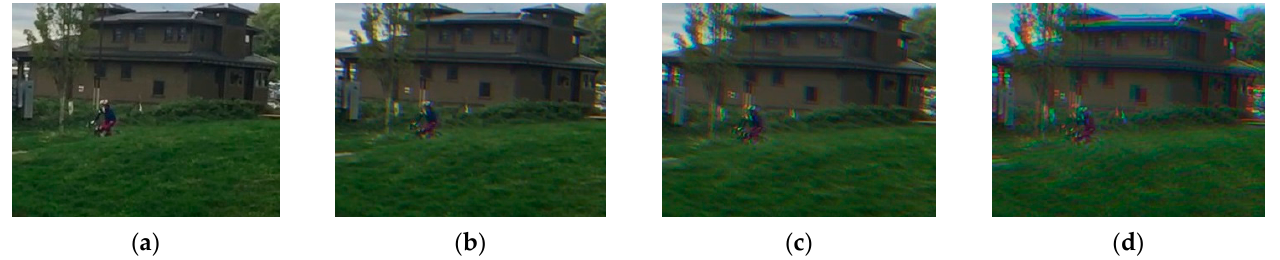
Figure 6. The generated images with different motion severity: ( a ) ground truth; ( b ) small motion; ( c ) medium motion; ( d ) big motion.